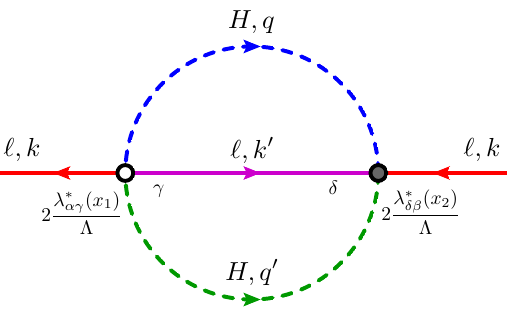
Figure 3 . The CP-violating time-dependent two-loop contribution to the lepton self-energy induced by the Weinberg